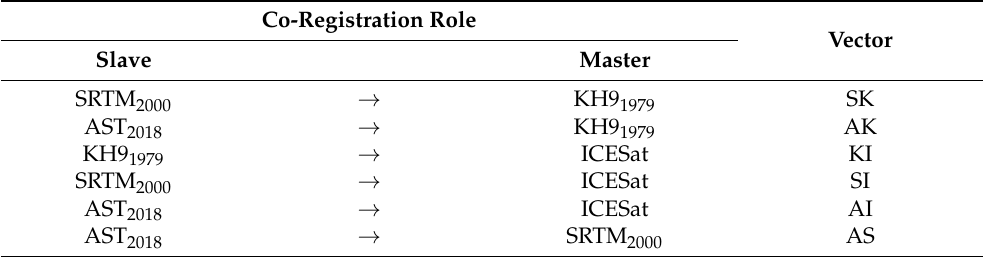
Table 5. DEMs and ICESat in co-registration role process. Note that SRTM 2000 → KH9 1979 is the only co-registration transformation that could be reached with both M1 and M2